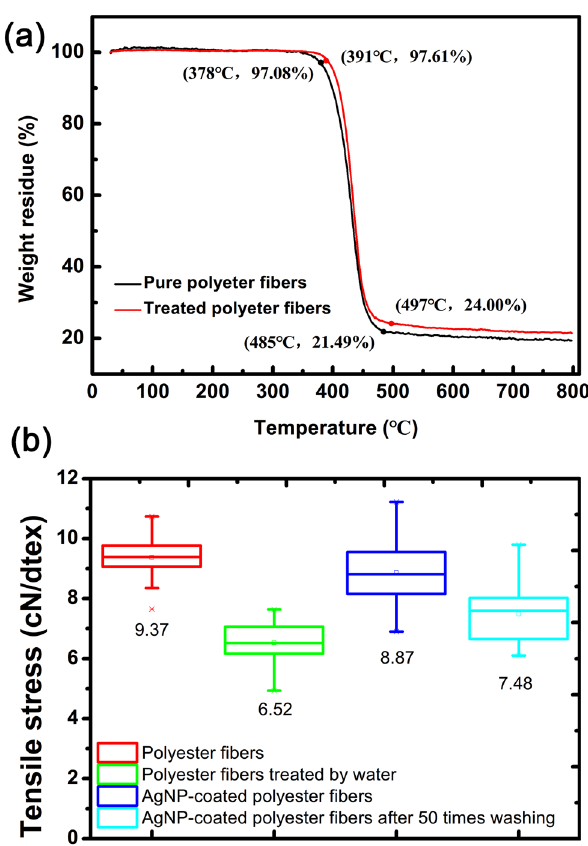
Figure 7: ( a ) The TG curves of raw polyester fi bers and treated polyester fi bers. ( b ) The tensile stress of pure and AgNP - coated polyester fi bers after 0 and 50 times of washing and that of the control sample treated by water under the same treatment conditions.